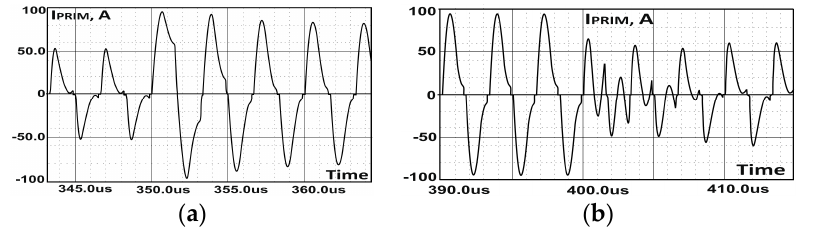
Figure 15. IPT efficiency vs output power and X&Y misalignment with 100 mm vertical air gap and power of 5–30 kW. The total max efficiency of the charging station from the mains to the battery at zero misalignment is 90–92%. This efficiency is obtained by the charging station modules in the following way: a) HF inverter 97–98%; b) IPT module 94–95%, primary 96–97% (copper app. 98%, ferrite core app. 98%), secondary 97–98% (copper app. 99%, ferrite core app. 98%); c) output rectifier 98–99%. 5. Conclusions The feasibility and advantages of a wireless power transfer charging station using dynamic matching and power supply with energy dosing have been introduced. Based on the analysis carried out, an IPT with compound ferrite cores having a 50–200 mm air gap was designed, which transfered the required electrical power (35 kW) to the battery. The equivalent circuit analysis and characteristics of the IPT system were presented. It has been shown that the magnetic coupling is an important parameter for IPT systems, as it determines the maximum transferred power and can have a great impact on system efficiency. Experiments were carried out to test the ability of the system with different air gaps and misalignments. The results showed that the system can transfer the specified electrical power with about 82–92% efficiency and that the IPT exhibited a high degree of stability under a misaligned (x-y-z) condition. As an HF power supply, an AI with ED was designed and implemented to verify the validity of the developed operating mode of energy dosing and control algorithm. The obtained expressions formulate the law for keeping the output power constant when the IPT and battery parameters are